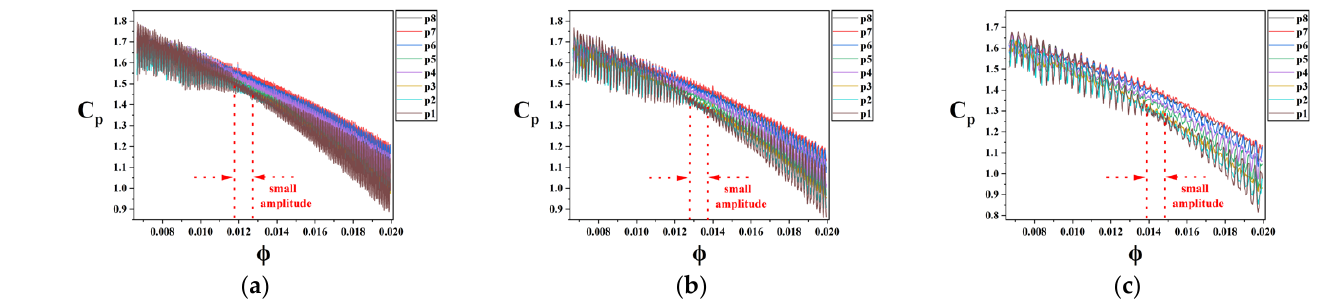
Figure 19. Pressure pulsations for Condition 2 ( a ), Condition 3 ( b ), and Condition 4( c ).